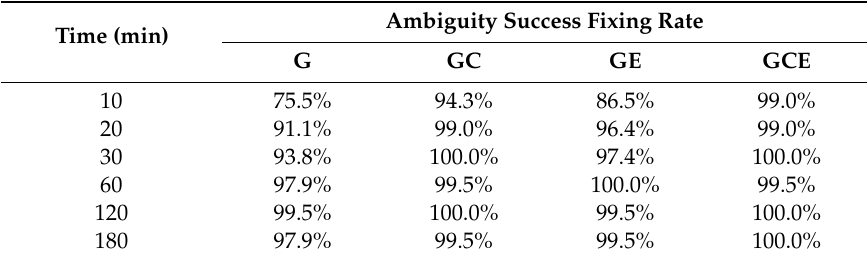
Table 4. Ambiguity success fixing rate in the di ff erent solutions at di ff erent